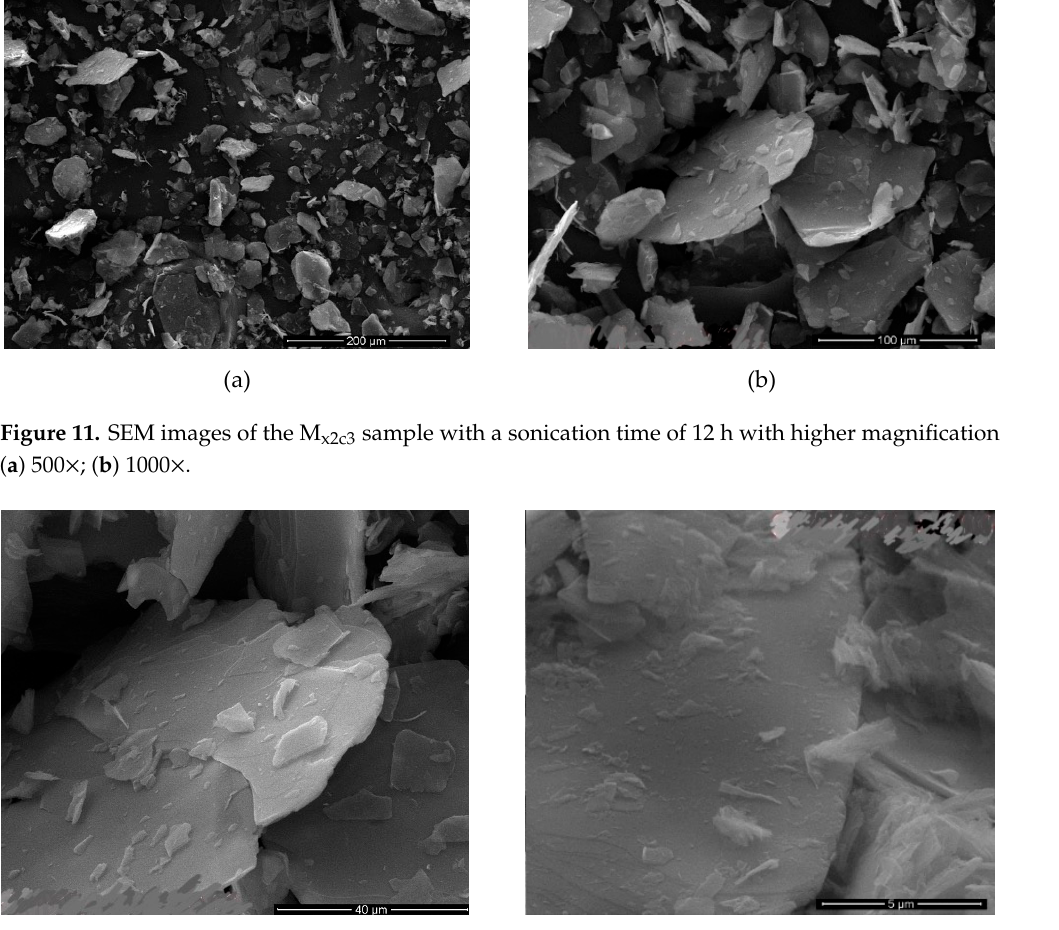
Figure 12. SEM images of the M x2c3 sample with a sonication time of 7 h with higher magnification ( a ) 3000×; ( b ) 20,000×.